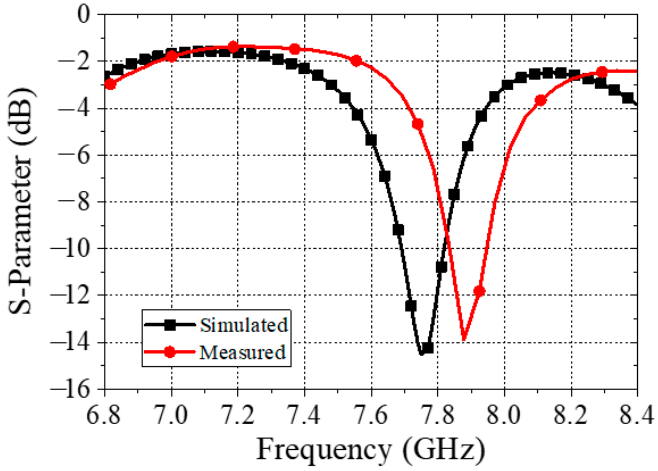
Figure 9. Simulated and measured S-parameter of the two-by-two series-fed patch array with one-by-two Wilkin power divider.